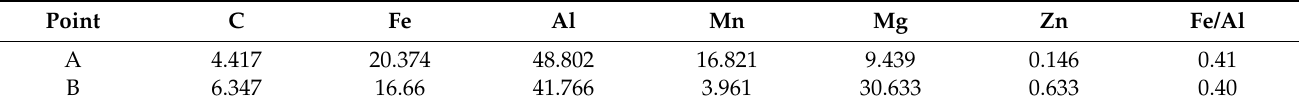
Figure 8. BSE micrographs of the interfacial magnification of ( a ) AZ63/galvanized Q235 and ( b ) AZ63/galvanized Q235 + T6. Table 3. EPMA results taken from points A and B in Figure 8 (at.%).